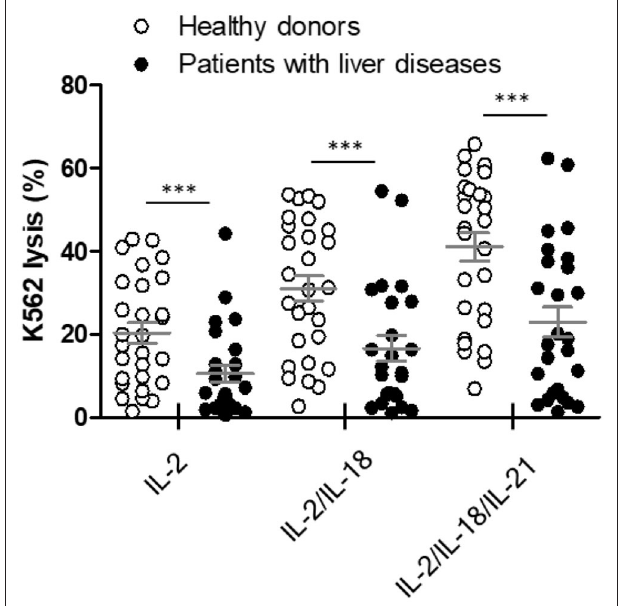
FIGURE 6 | Comparison of natural killer (NK) cytotoxicity in healthy donors ( n = 28) and patients with liver diseases ( n = 26) using the whole blood (WB)-based NK cytotoxicity assay (200 µ L). WB was activated overnight with IL-2, IL-2/IL-18, and IL-2/IL-18/IL-21. Data are represented as the mean ± SEM (*** p <